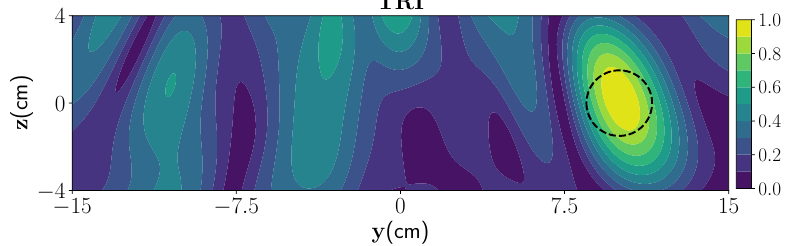
Figure 10. Reconstruction of one wet spot using TRI-DORT for moderate random rough